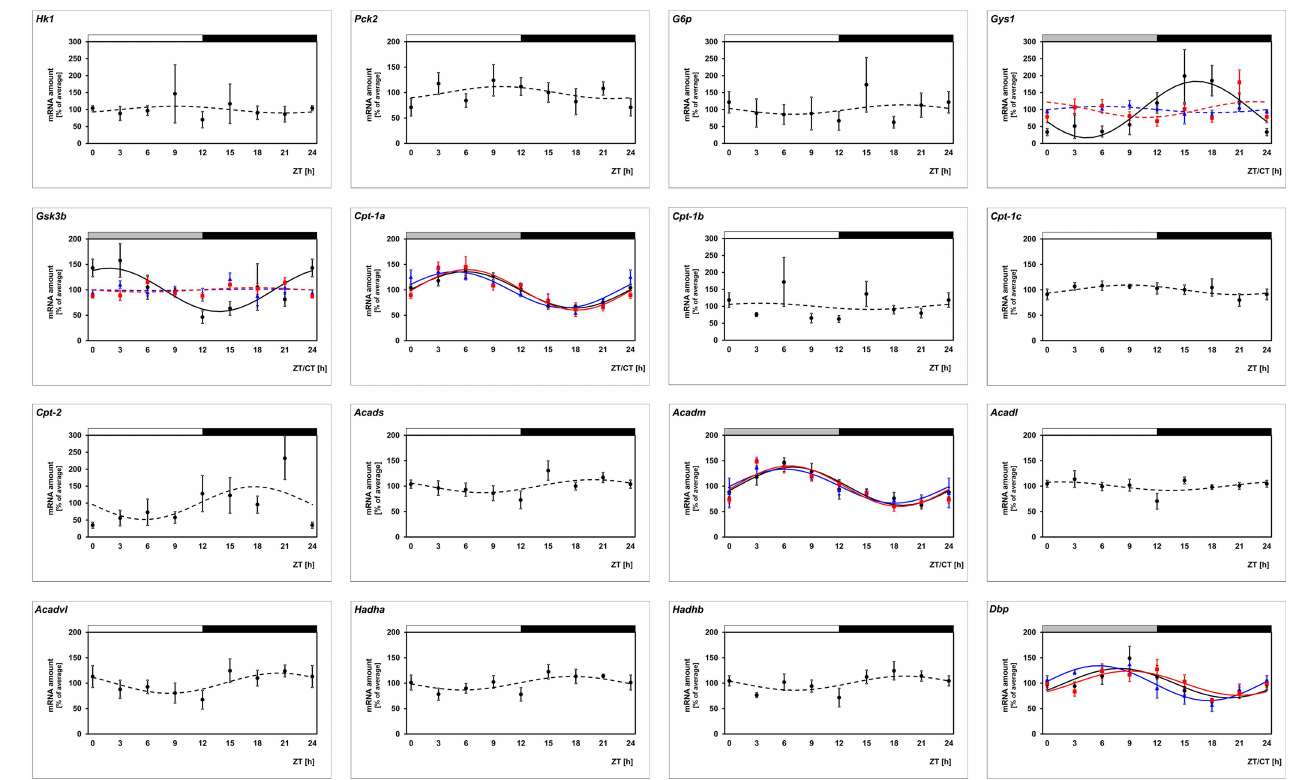
Fig 1. Transcriptional screening of key enzymes of energy metabolism to be under daily and circadian regulation in retina and photoreceptor cells. Transcript levels of key enzymes of glycolysis ( Hk1 ), gluconeogenesis ( Pck2 and G6p ), glycogensynthesis ( Gys1 and Gsk3 ) and fatty acid oxidation( Cpt-1a , Cpt-1b , Cpt-1c , Cpt-2 , Acadm , Acads , Acadl , Acadvl , Hadha , Hadhb ) are recorded in preparations of the whole retina under light/dark (LD) 12:12 (black lines), in preparations of the whole retina under constant darkness (DD) (blue lines) and in microdissected photoreceptor cells (PRCs) under light/dark (LD) 12:12 (red lines) using qPCR. The mRNA levels are plotted as a function of Zeitgeber time (ZT) and the lines represent the periodic sinusoidal functions determinedby cosinor analysis(solid and broken line for p < 0.05 and p > 0.05 in cosinor analysis). Data represent a percentageof the average value of the transcript amount during the 24-h period. Statistical analysis of transcriptional profiling is provided in Table 2. The value of ZT0 was plotted twice at both ZT0 and ZT24. The solid bars indicate the dark period. Each value represents mean ± SEM (n = 4; each n represents two animals / four retinae). Note that the FAO genes Cpt-1 α and Acadm as well as the reference gene Dbp exhibit significant fluctuations in all